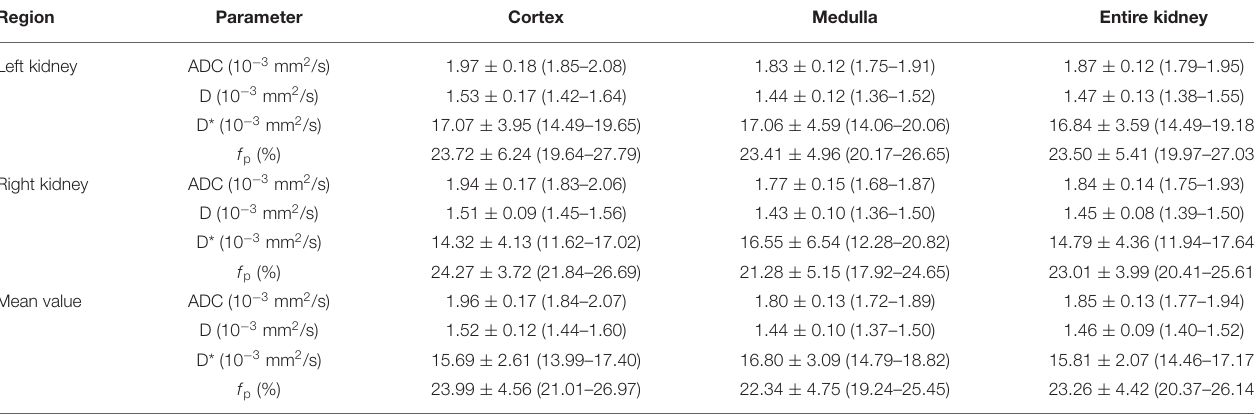
TABLE 2 | The ADC, D, D * and f p values measured from the renal cortex and medulla, and the entire kidney, derived from IVIM analysis in healthy beagle dogs. Region